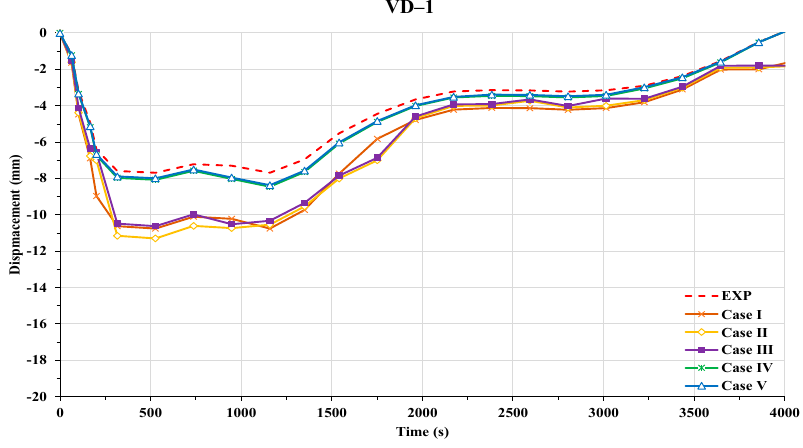
Figure 20. Displacement over time at VD-1.